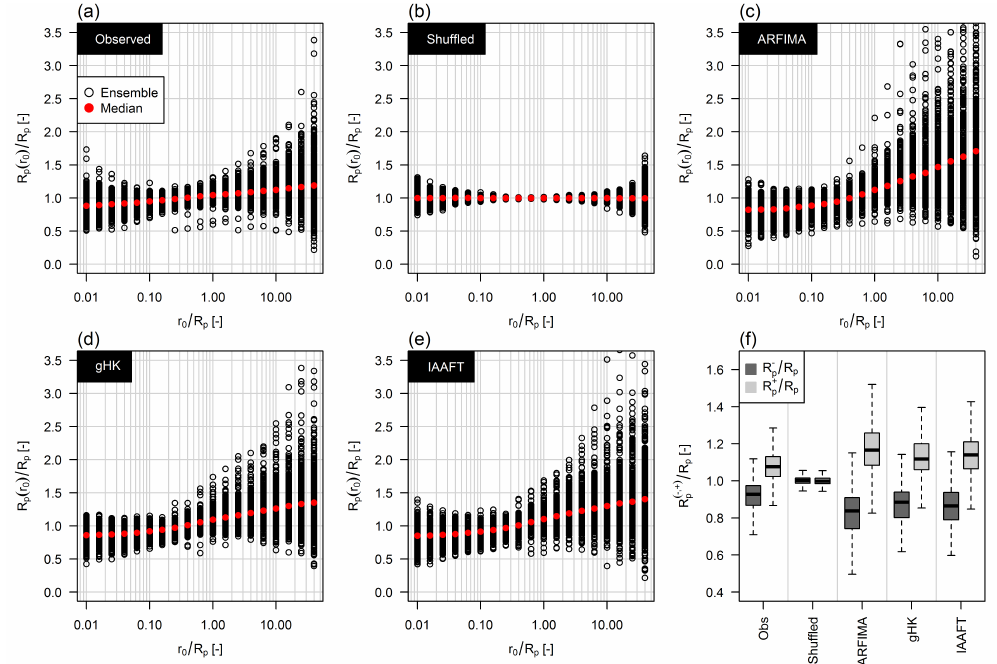
Figure 11. ( a – e ) Standardized conditional return periods versus conditioning values of return intervals; ( f ) Box plot of standardized conditional return periods R − p / R p and R + p / R p conditioned on the values of return intervals below ( − ) and above (+) the median; Results in panel ( f ) correspond to those in panels ( a – e ) but for only two classes of conditioning